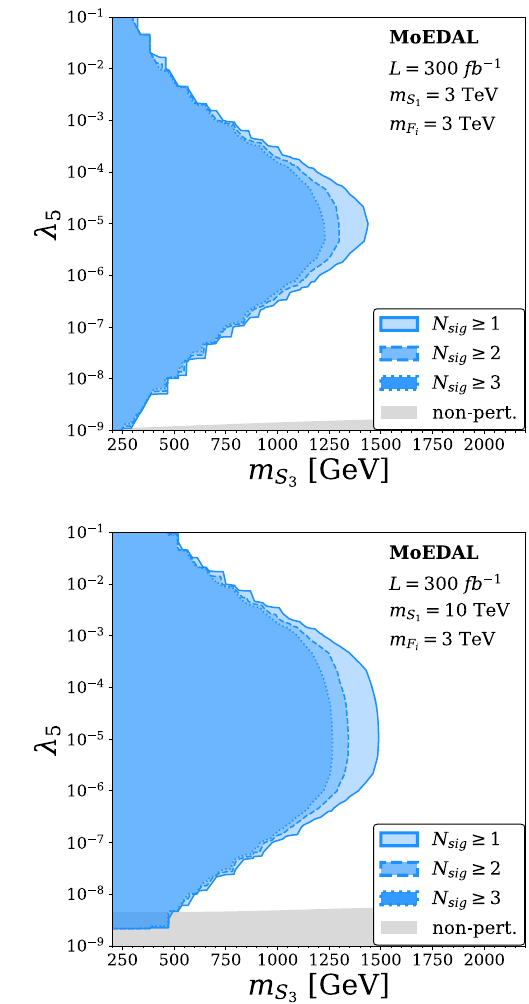
Fig. 7 MoEDAL’s detection sensitivity for Model-1 in the ( m S plane. In the regions inside the solid, dashed and dotted contours, MoEDAL expects to observe more than 1, 2 and 3 events, respectively. The region with N sig ≥ 3 will be excluded at 95% CL if MoEDAL does not observe any signal event. The left and right panels correspond to